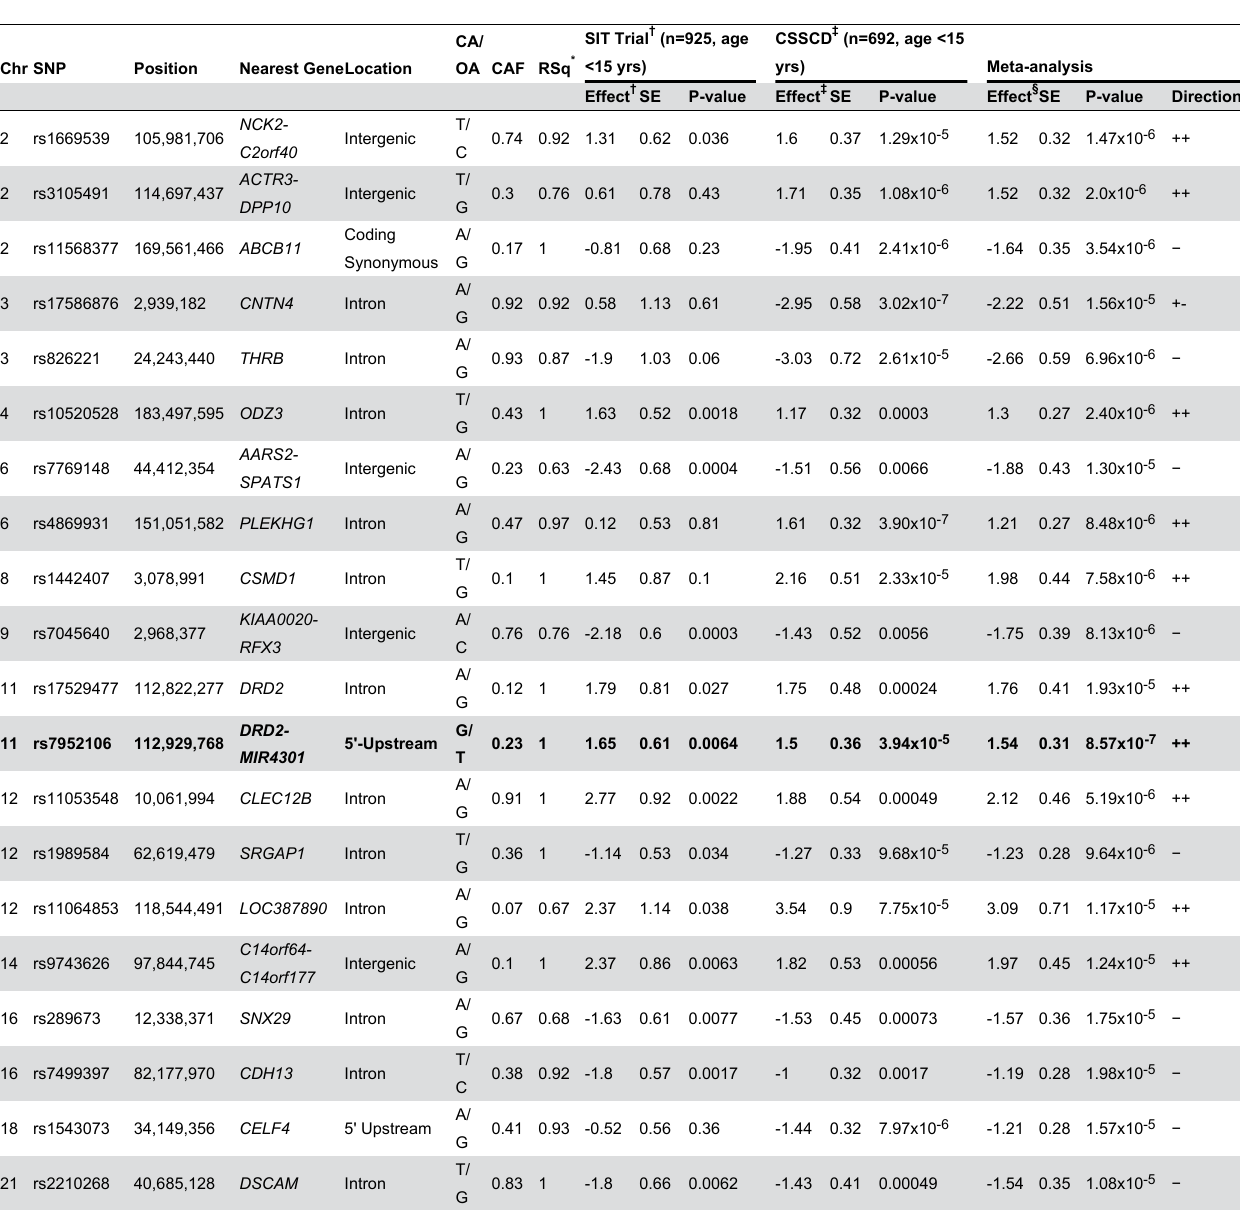
Table 2. Association summary of top scoring independent loci of systolic blood pressure